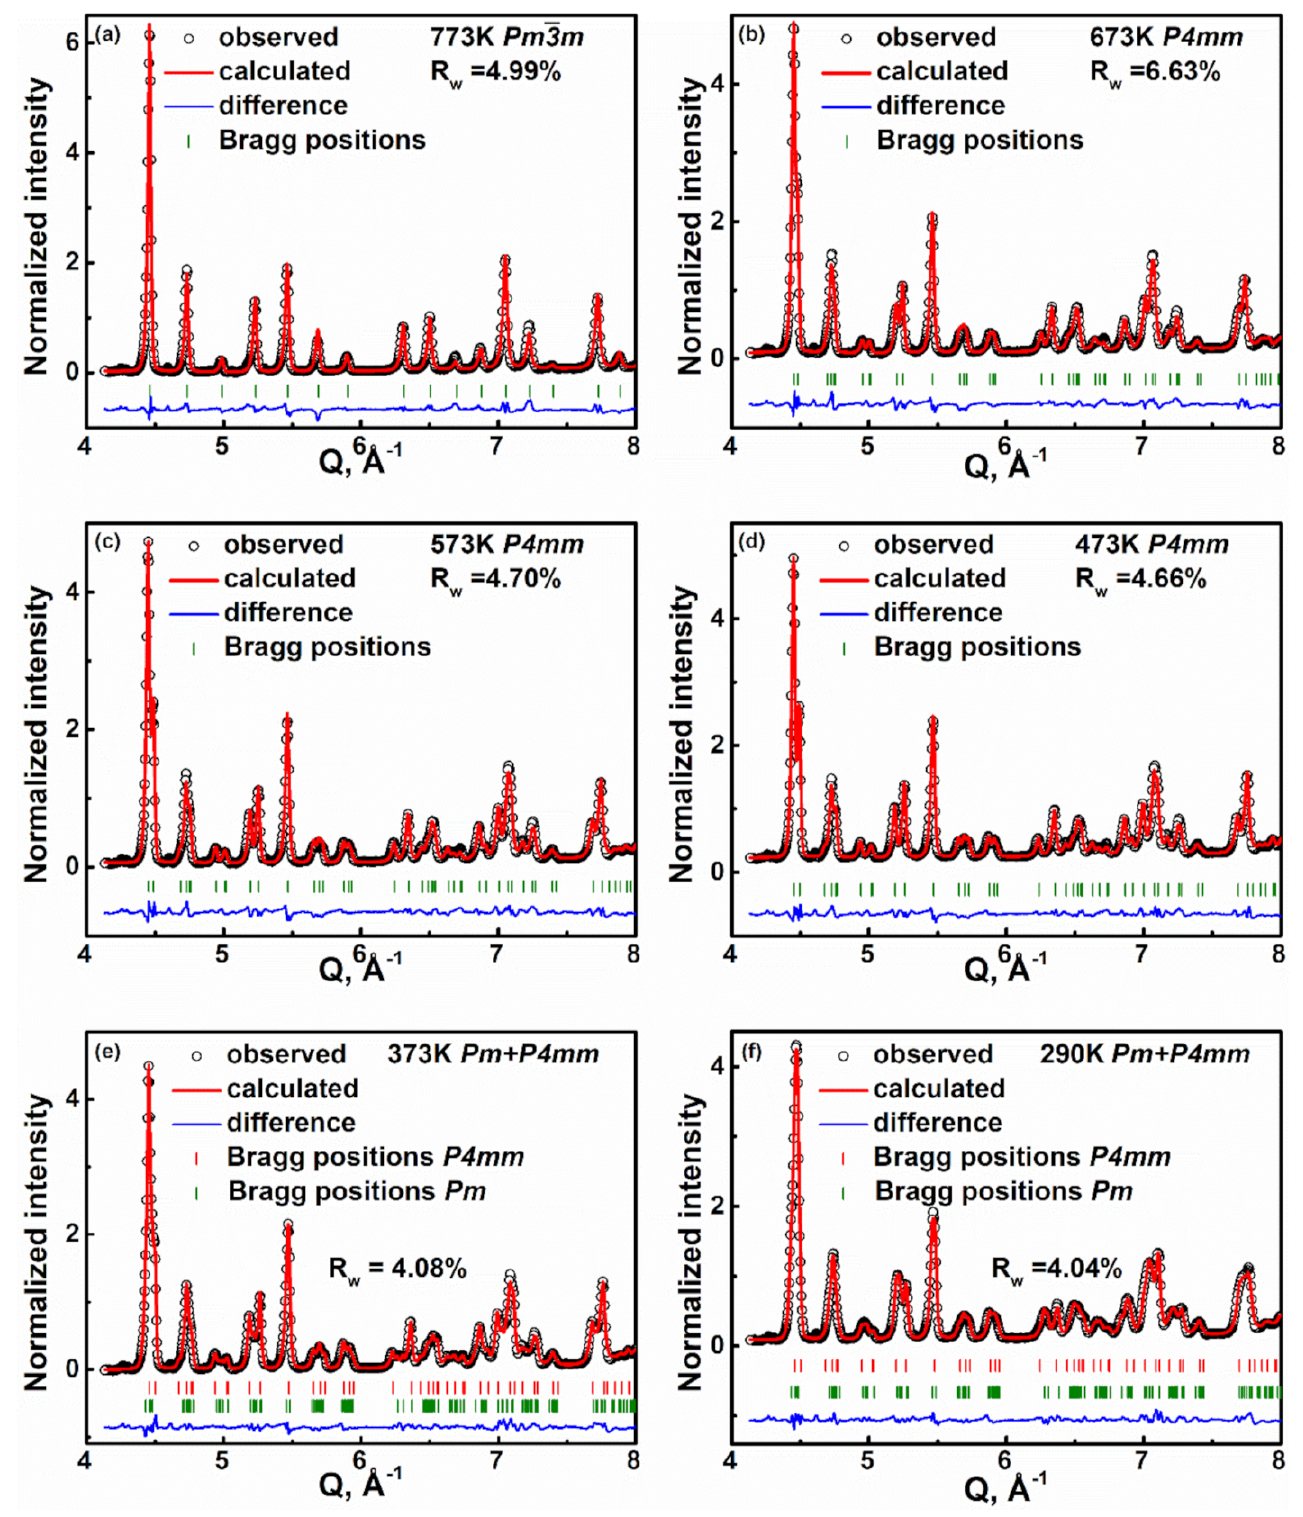
Figure 2. Diffraction patterns of KNNL6 powder at different temperatures showing measured (black symbol), refined (red line), difference (blue line) profiles, and Bragg positions (green ticks). The data shown is from BANK 5 of the NOMAD instrument. ( a ) Pm 3 m at 773 K; ( b ) P4mm at 673 K; ( c ) P4mm at 573 K; ( d ) P4mm at 473 K; ( e ) P4mm and Pm at 373 K; ( f ) P4mm and Pm at 290